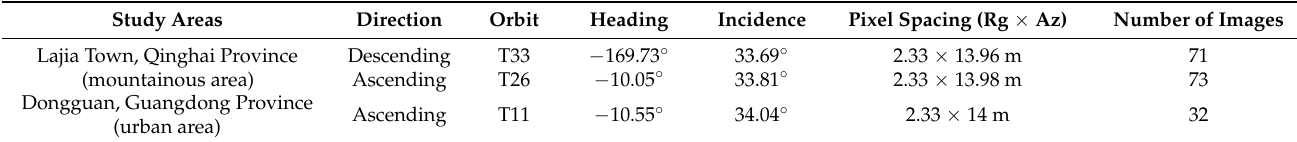
Figure 7. Flowchart of the MT-InSAR data processing. Table 2. Parameters and acquisition dates of the images used in this